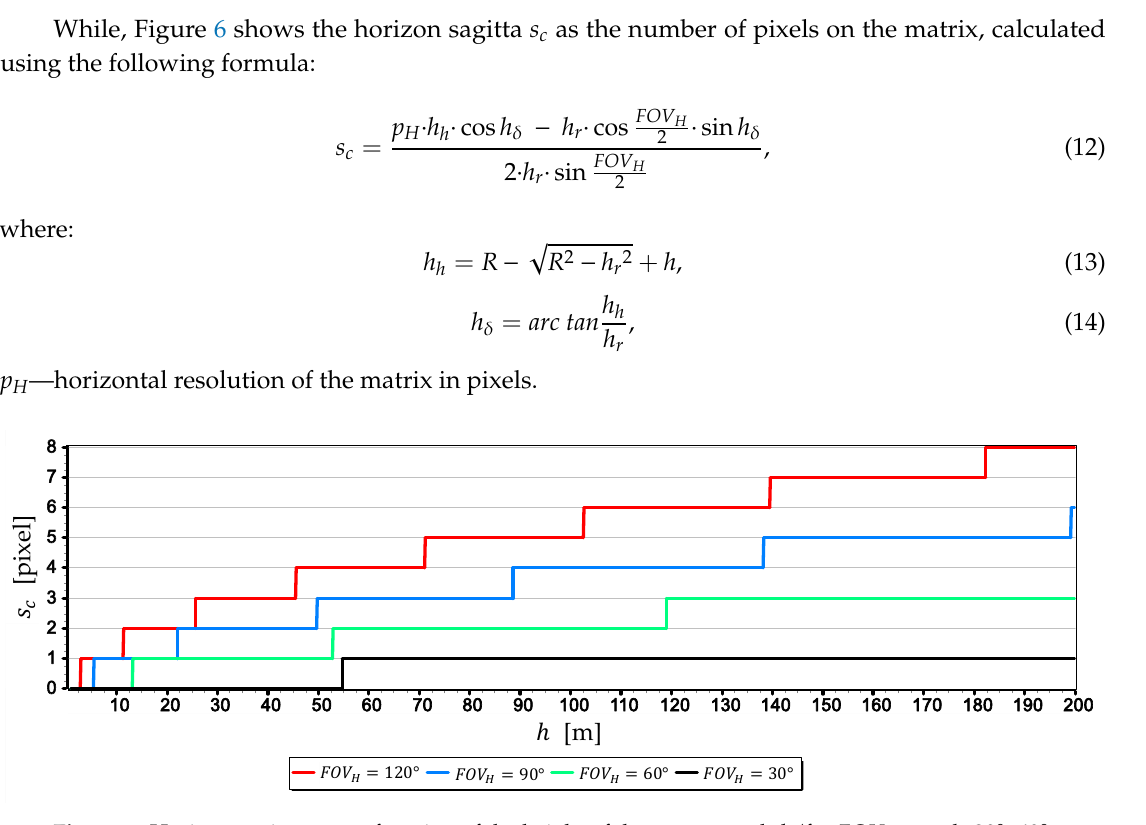
Figure 6. Horizon sagitta s c as a function of the height of the camera a.s.l. h (for FOV H equals 30 ◦ , 60 ◦ , 90 ◦ and 120 ◦ , R = 6,378,000.0 m, k = 0.16, p H = 4000 pixels).